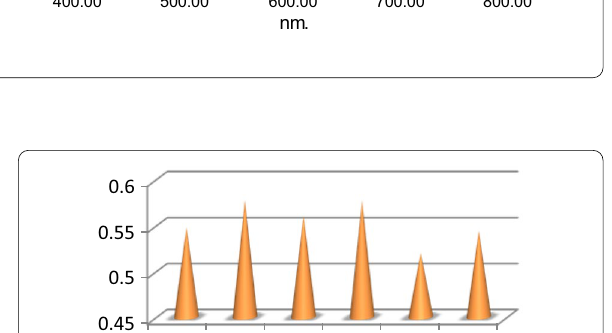
Fig. 9 a Before sterilization, b after sterilization